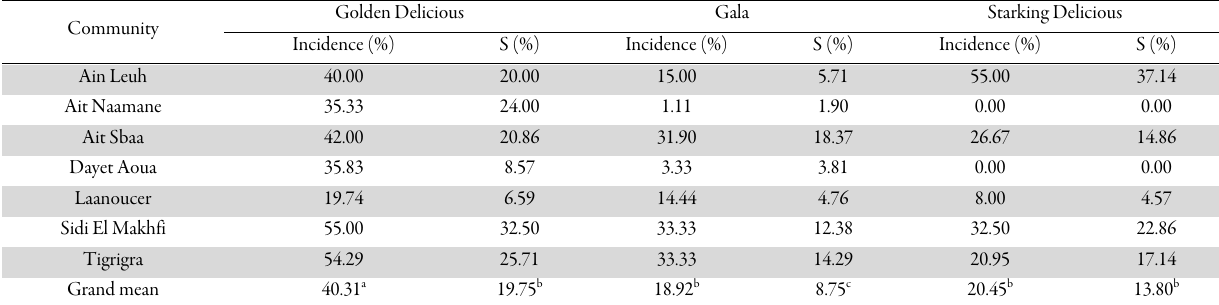
Table 1. Prevalence of apple scab in the seven districts of the Sais region Community